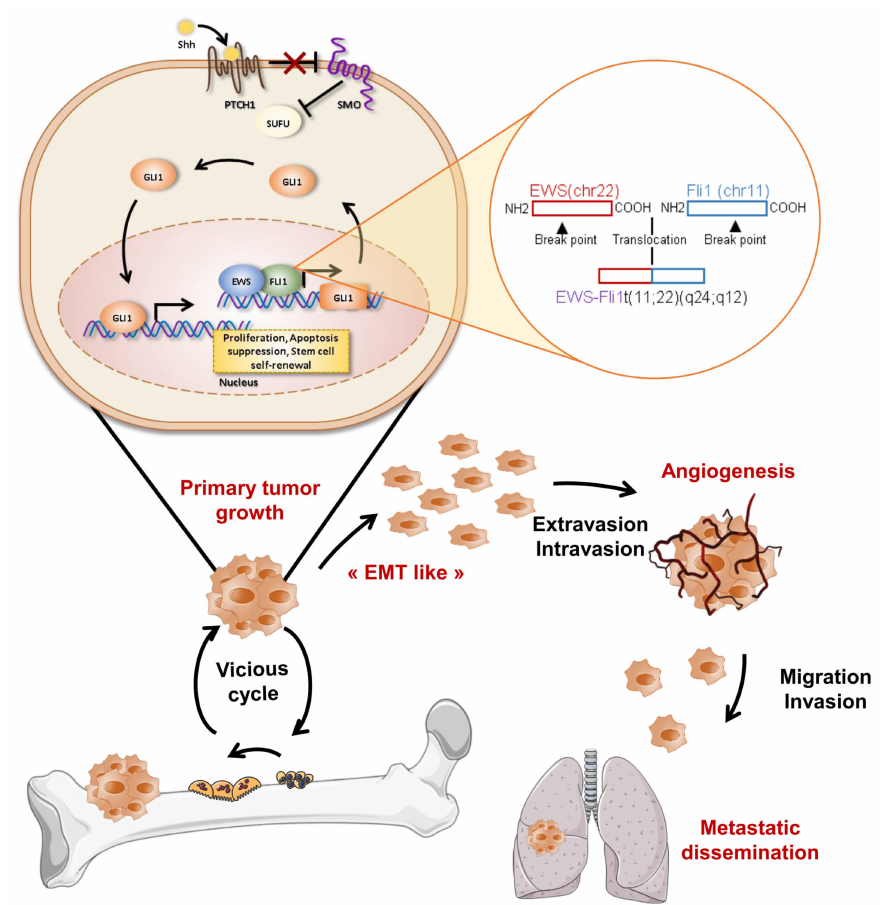
Figure 4. Role of SHH / Gli cascade in Ewing sarcoma development. Upper panels: EWS-Fli1 protein regulates Gli1 gene expression at the transcriptional level and, therefore, promotes the expression of Gli gene targets implicated in various cellular events, such as cell proliferation and migration. Lower panels: progression of Ewing sarcoma development. During primary tumor growth, cancer cells produce soluble factors, such as growth factors or cytokines, that activate osteoclastogenesis and, in turn, bone degradation. This bone resorption then allows the release of trapped growth factors into the bone matrix able to stimulate tumor growth, “EMT-like” (epithelial mesenchymal transition) angiogenesis and, therefore, the metastatic